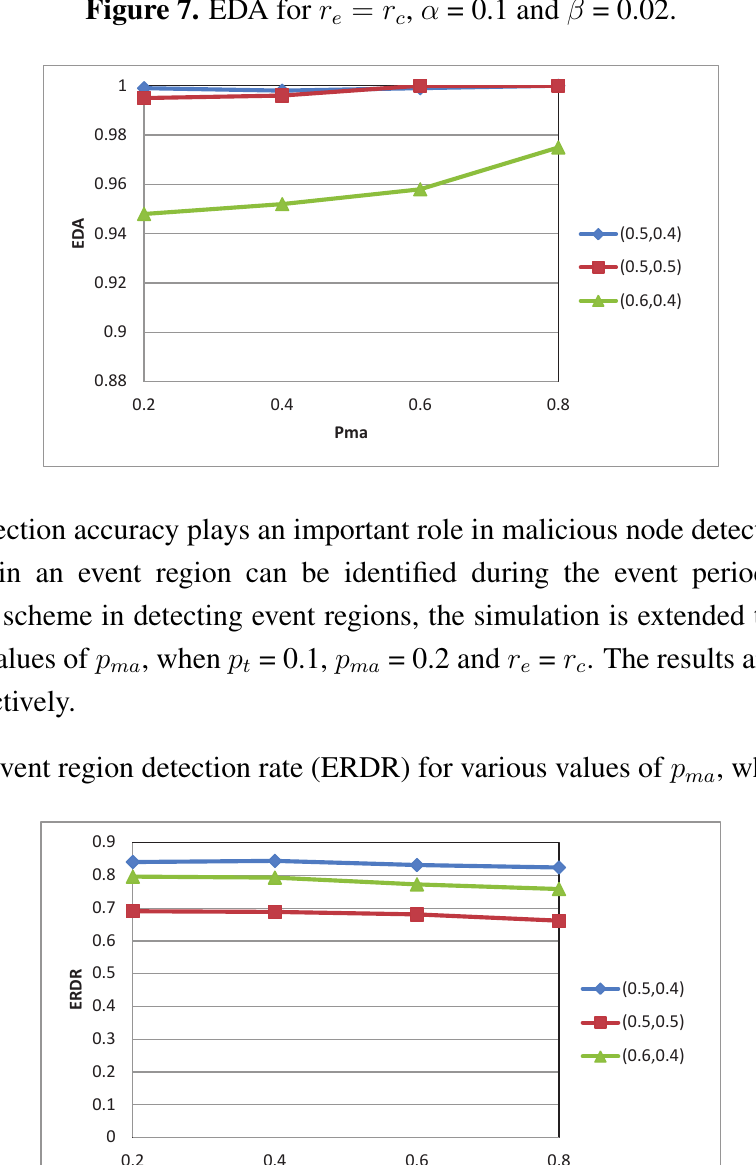
Figure 7. EDA for r